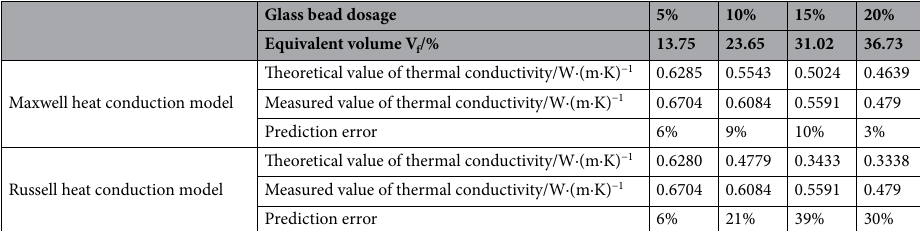
Thermal conductivity of filling matrix /W·(m·K)